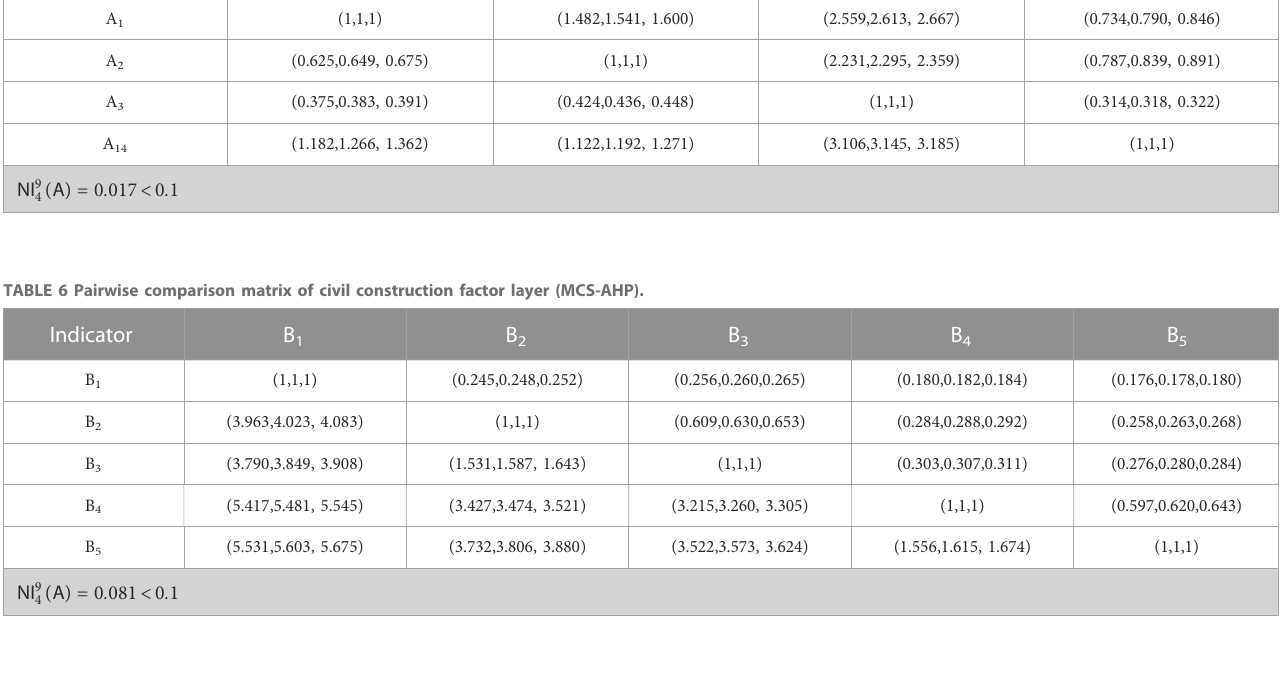
TABLE 7 Pairwise comparison matrix of installation and construction factor layer (MCS-AHP).